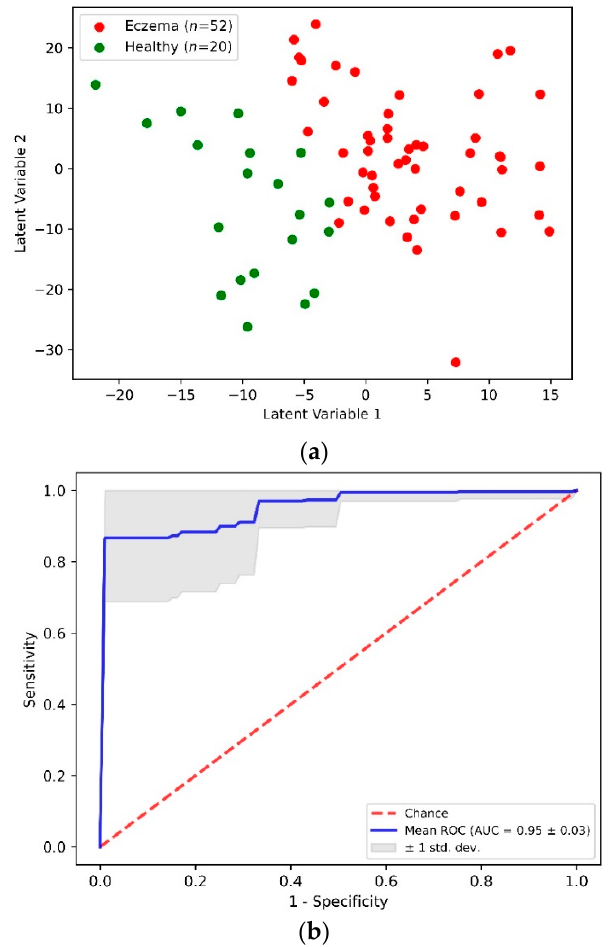
Table 2. Classification metrics from the PLS ‐ DA binary classification model using the stratified K ‐ fold (K = 10) cross validation method for eczema ( n = 52) and healthy ( n = 20) subjects.